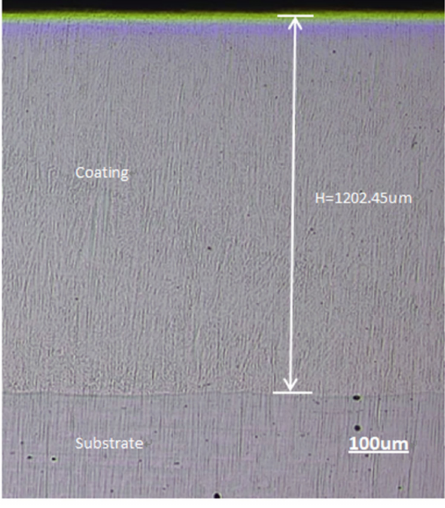
Figure 1. Thickness of the cladding layer and cross-sectional micromorphology